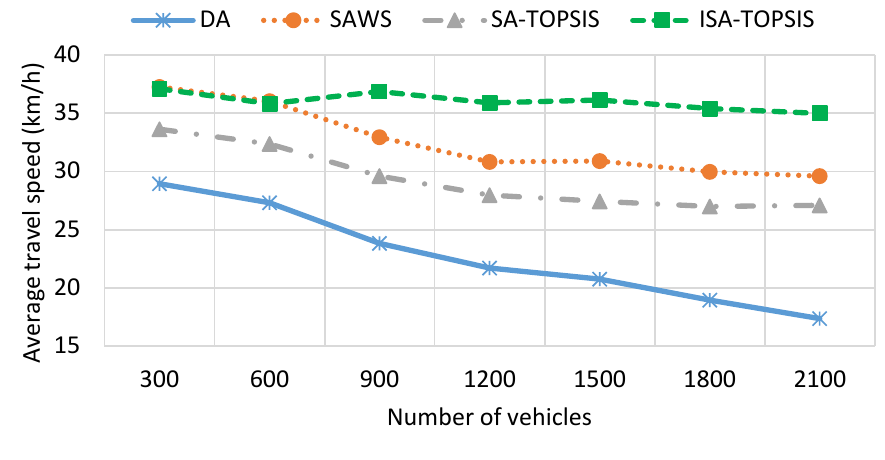
Figure 11. Average travel